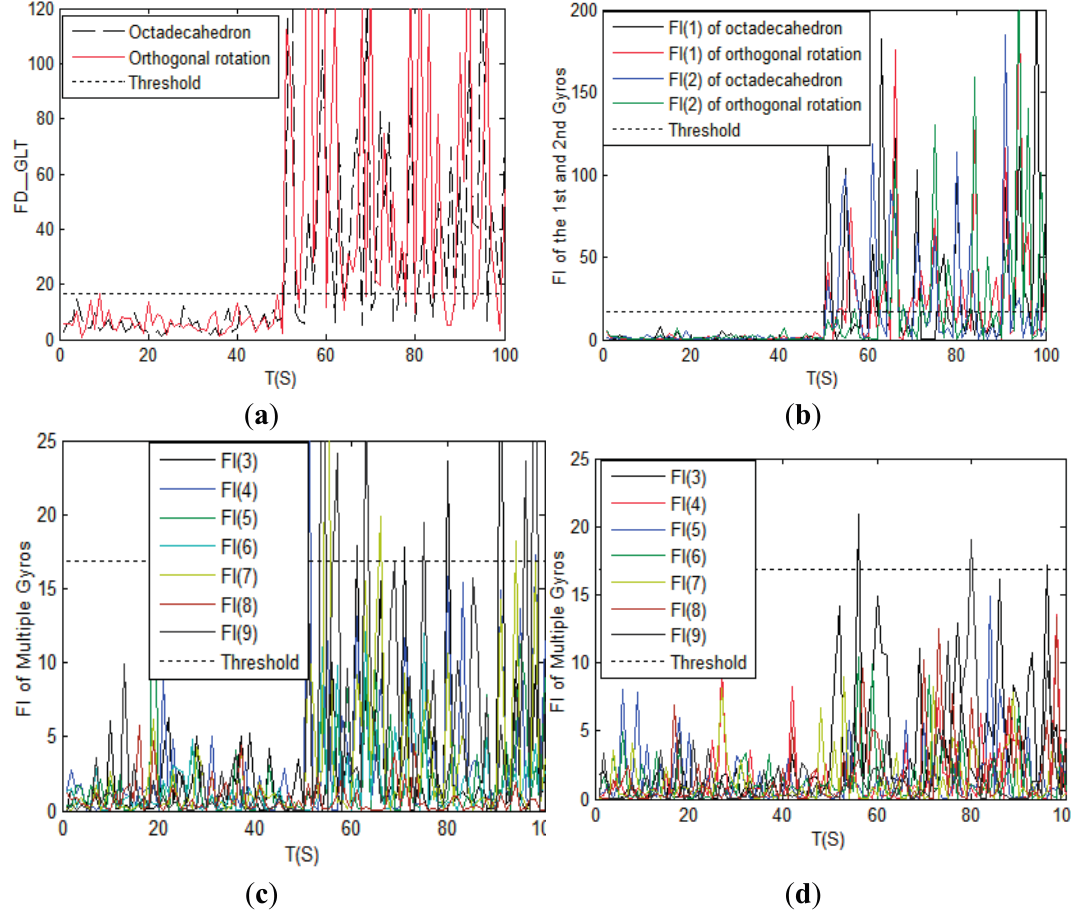
Figure 7. Comparison of double-fault detection and isolation of the octadecahedron and the orthogonal rotation configurations: ( a ) Fault judgment curves; ( b ) Fault detection curves of the 1st and the 2nd gyro; ( c ) Fault detection curves from the 3rd to the 9th of the octadecahedron scheme; ( d ) Fault detection curves from the 3rd to the 9th of the orthogonal rotation